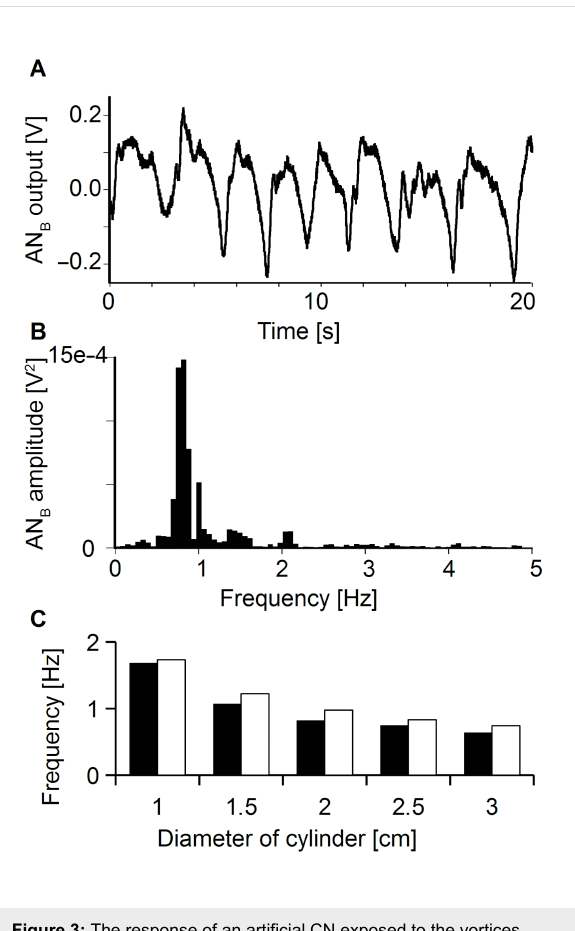
Figure 3: The response of an artificial CN exposed to the vortices shed from a stationary cylinder (diameter 2 cm) (A) and frequency spectrum of the response (B). Peak frequency (0.82 Hz) was similar to the calculated vortex shedding frequency (0.98 Hz). (C) Measured (black bars) and calculated (white bars) vortex shedding frequencies for cylinders of different